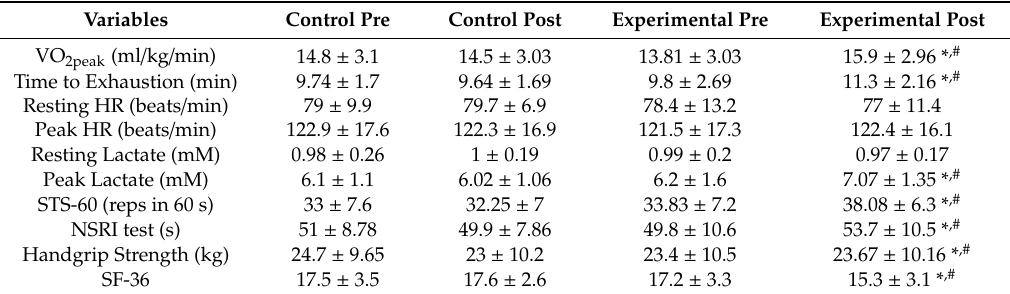
Table 4. Changes in participants’ physical performance status.